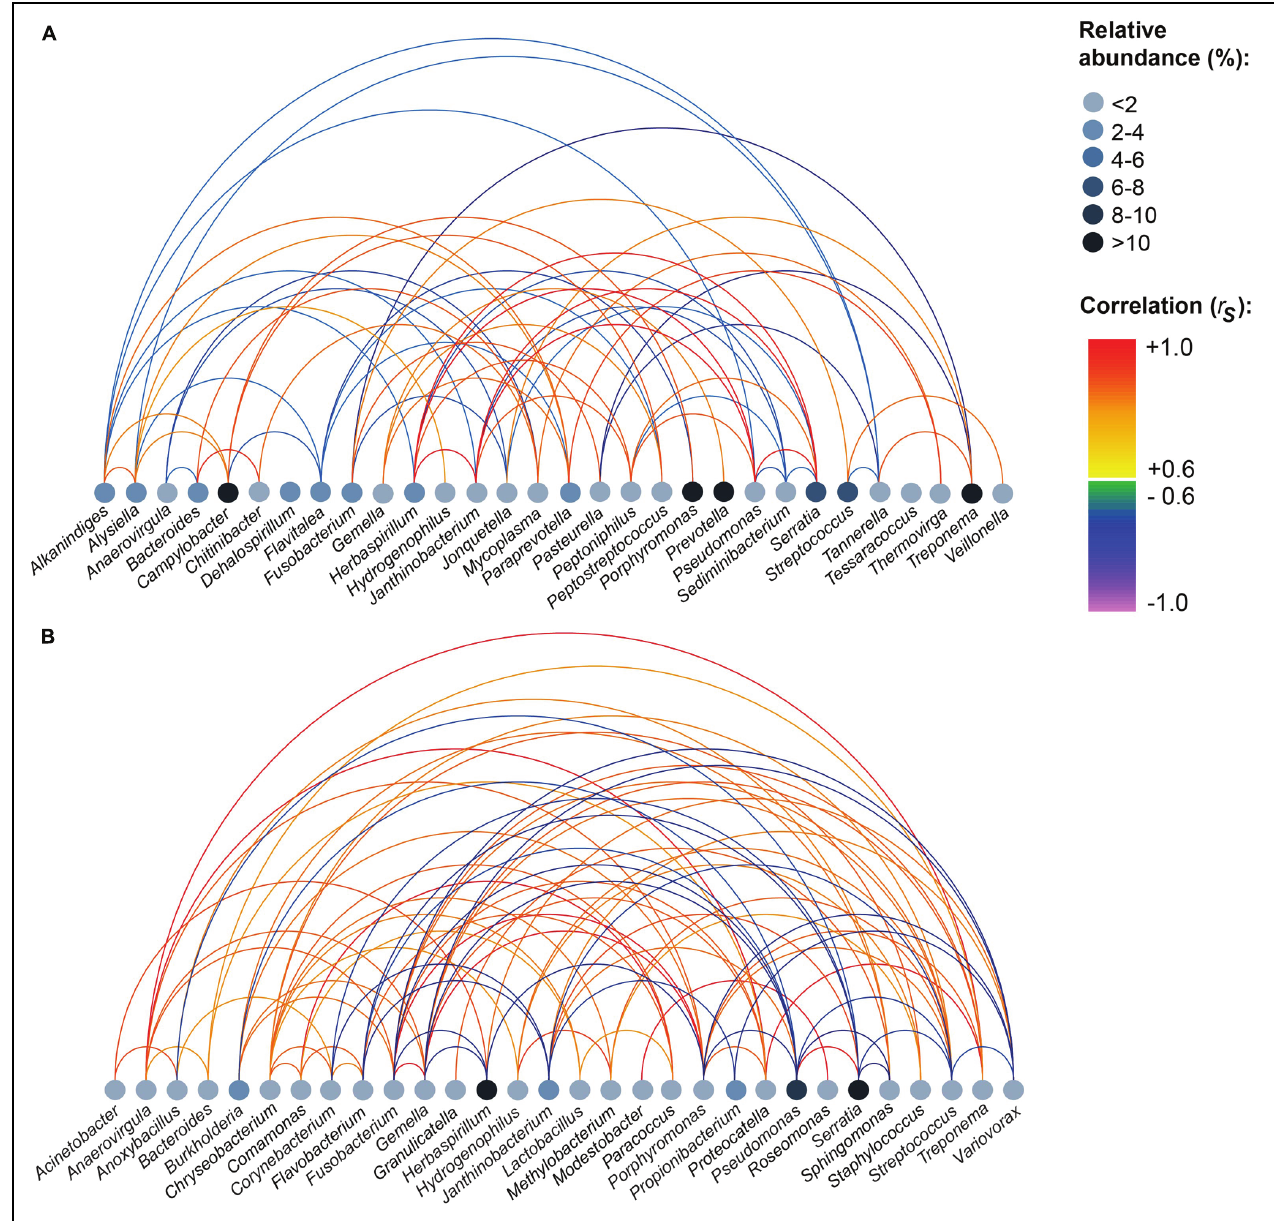
FIGURE 3 | Strong positive and negative correlations between genera within all samples of each sampling site. (A) Tonsils, (B) mandibular lymph nodes. Pairwise Spearman correlations ( r s ) between the most abundant genera were computed for each tissue. Relative abundances of genera are indicated by node color. The color of the edges indicates the degree of correlation. The figure depicts correlations | r s | ≥